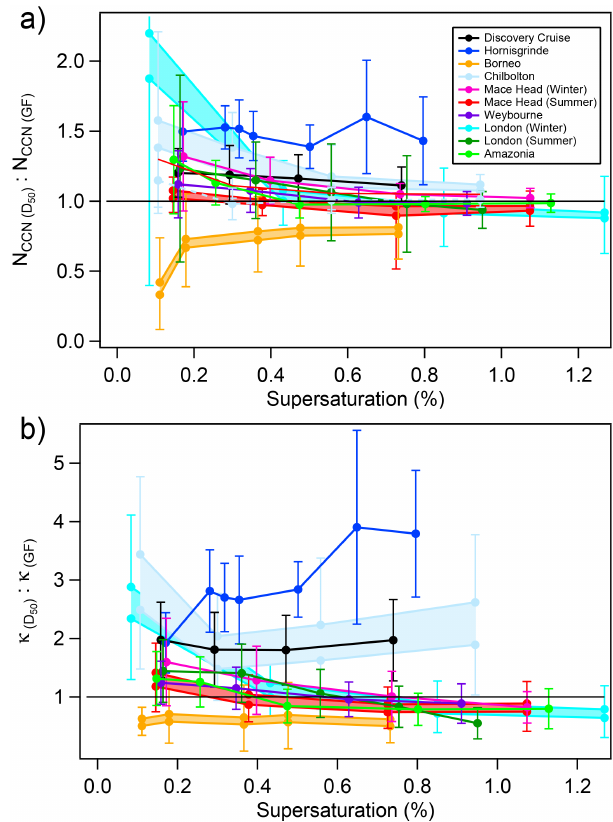
Figure 3. Ratios of mean D 50 and GF derived (a) N CCN and (b) κ values as a function of S set for each measurement campaign. Error bars represent one standard deviation. The shaded areas rep- resent the spread of values due to differing HTDMA